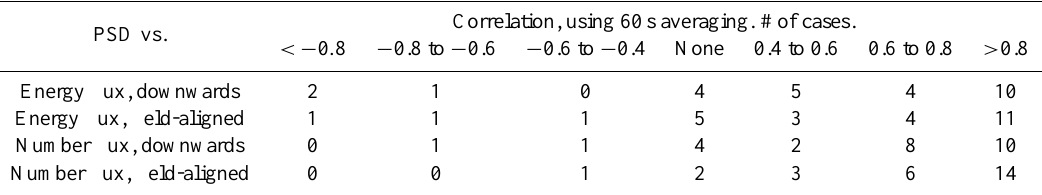
Table 2. Each row shows a summary of the correlation coefficients of the Power Spectral Density (PSD) of the electric field fluctuations around 1Hz versus one type of ion flux, with each column containing the number of cases with a correlation within the interval shown in the column header. 60s averages of the wave power and flux levels were used for the calculations. The total number of cases is 26. “field-aligned” flux is the sum of the absolute values of upward and downward flux. Correlation, using 60s averaging. # of cases. PSD vs.